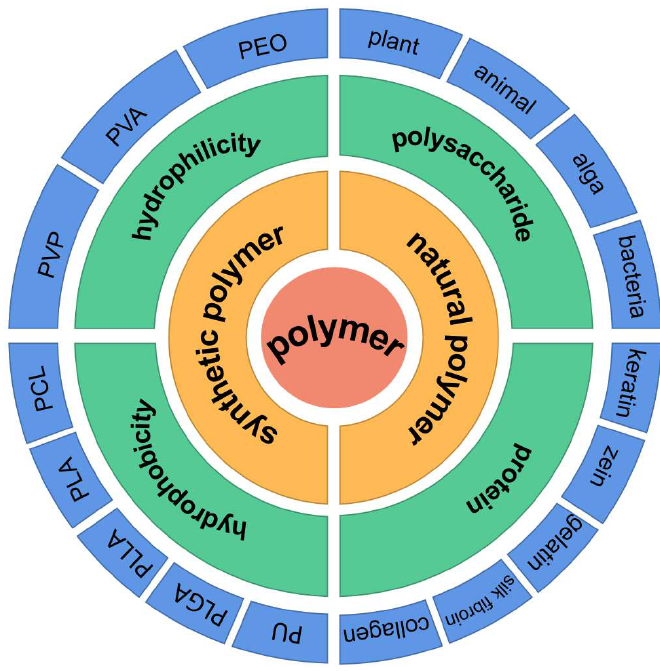
Figure 6. Classification of polymers used in electrospun herbal medicine nanofibers.